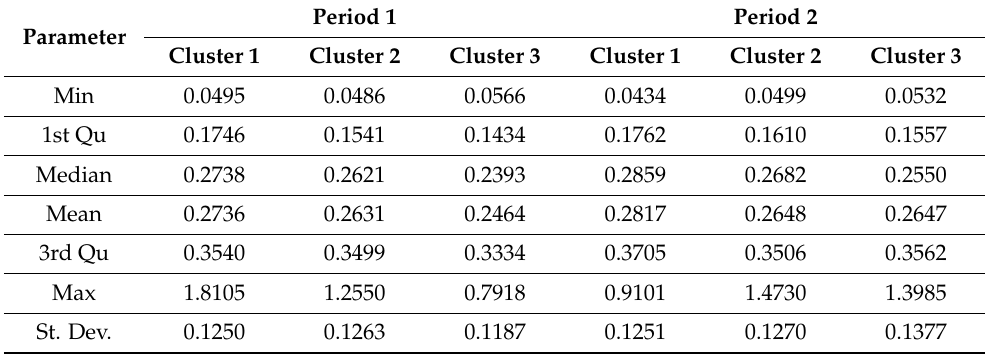
Table 11. Descriptive statistics of the power-line flicker in phase L2 at the tested measuring point.